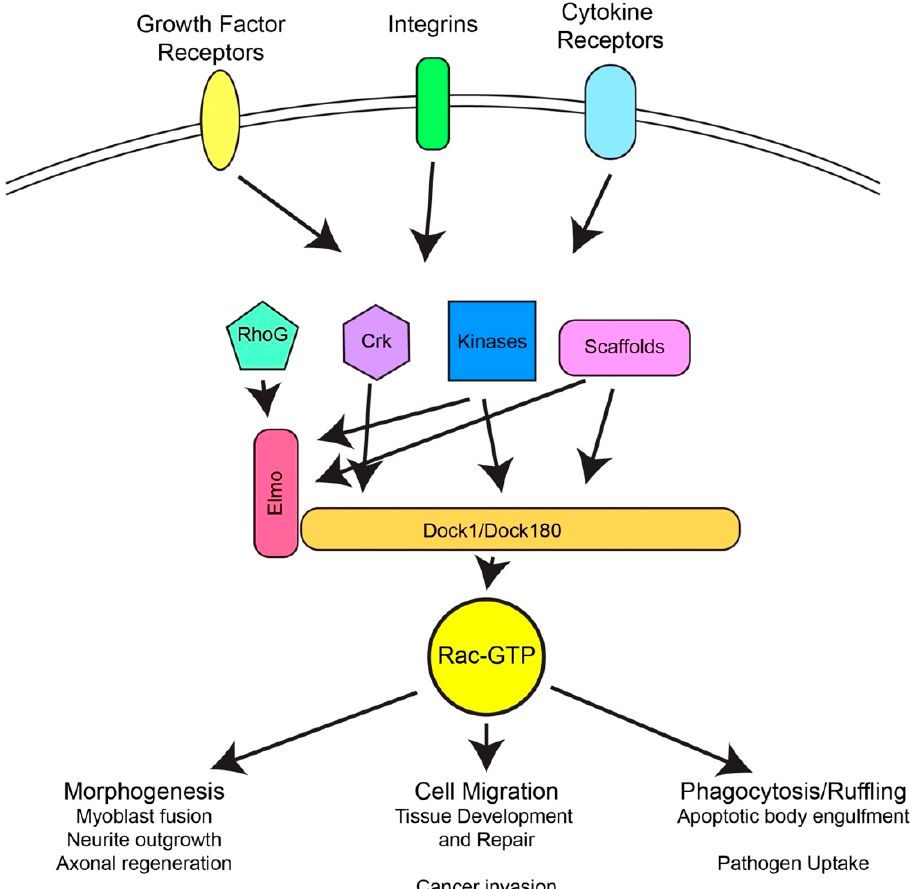
Figure 3. The Activators and Impacts of Dock180 dependent Rac Activation. Dock180 dependent Rac activation is enhanced by receptors via RhoG interaction with Elmo, Crk interaction with Dock180, phosphorylation of Elmo or Dock180 and/or scaffold protein dependent recruitment of Elmo or Dock180. The localized activation of Rac by Dock180 stimulates morphogenesis, cell migration and phagocytosis in a variety of normal and pathological contexts.